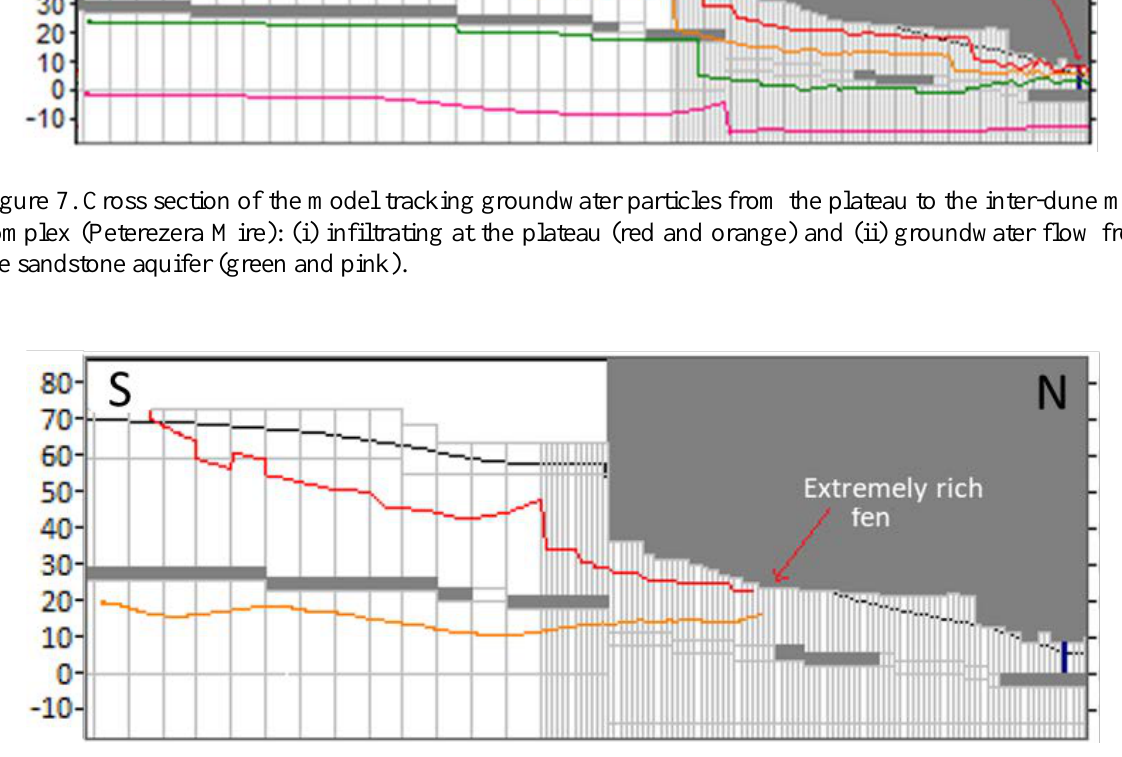
Figure 8. Path lines of two groundwater particles reaching the extremely-rich fens at the foothill of the plateau: (i) infiltrating at the plateau (red) and (ii) from the sandstone aquifer below the clay lenses (orange).